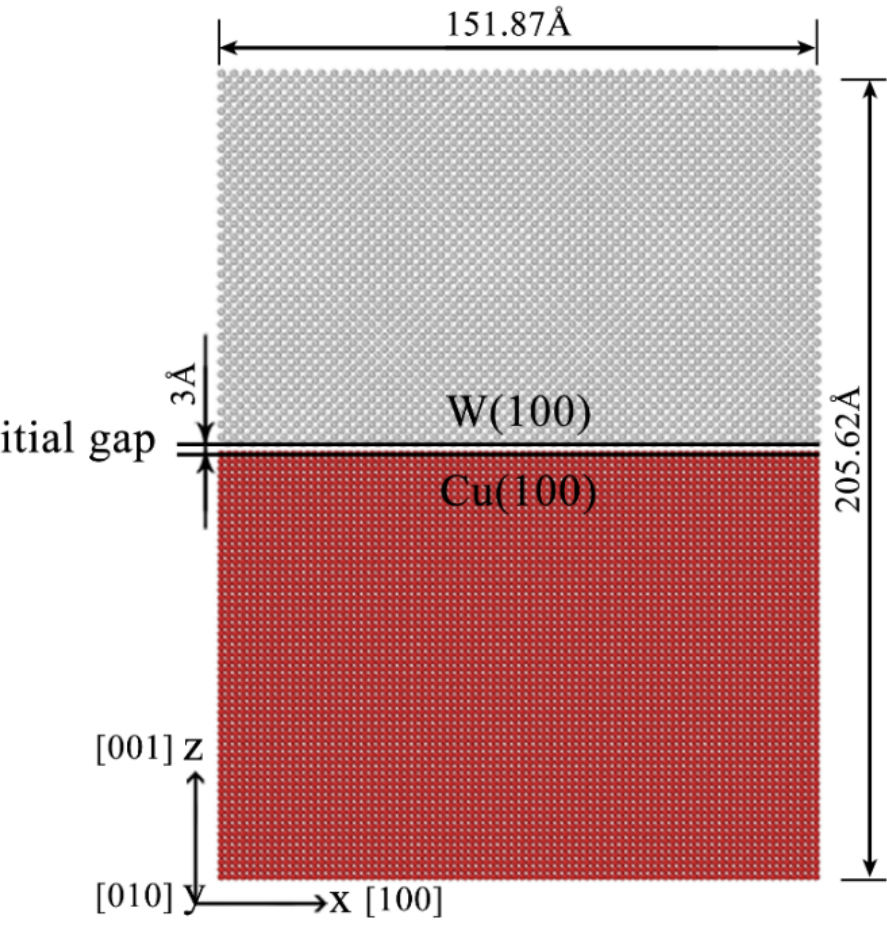
Figure 1. Initial interface model used for molecular dynamic simulations of direct alloying between Cu and W, where the upper layer is the W layer, and the lower layer is the Cu layer.